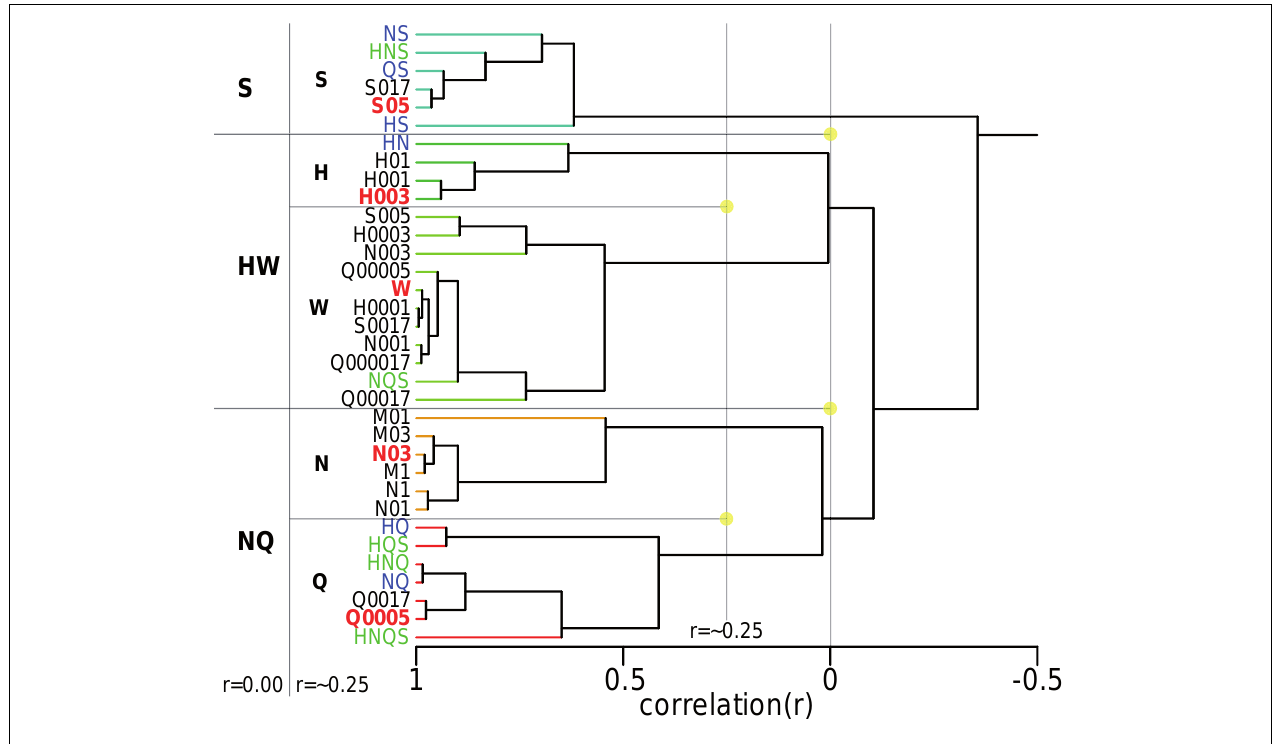
FIGUREA4 | luster analysis of basics only. Five clusters are derived at an inter cluster correlation between ∼ r = 0.0 and ∼ r = 0.4.The largest cluster consists of weak